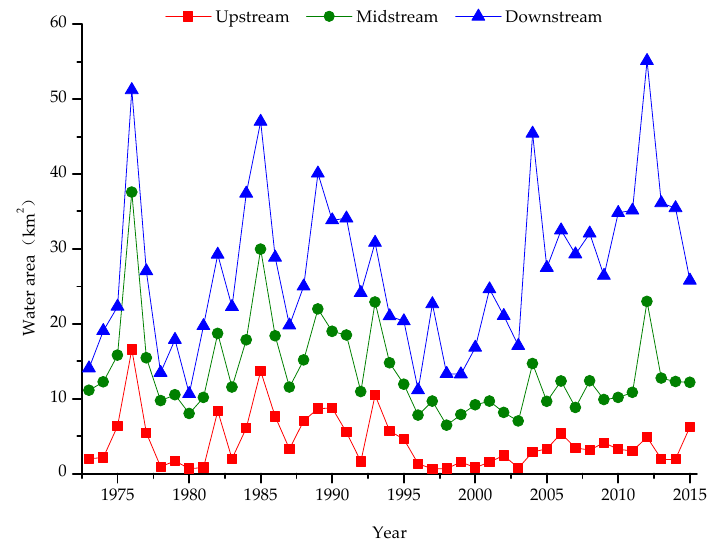
Figure 3. Corresponding water area of EBF in the dry season from 1973 to 2015.